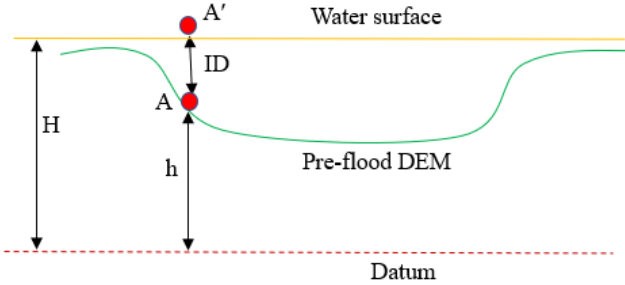
Figure 3. A schematic description of inundation depth estimation. Figure 3 represents a cross-section of a 3D water surface or mask (yellow line) and a cross-section of the pre-flood DEM and datum that are shown by green profile and red dashed line, respectively. H is the elevation of the water surface above the datum, h is the elevation of the earth's surface before the flood event, and ID is the inundation depth. Assume A is a point (pixel) on the earth's surface and A′ is the location of the correspond- ing point on the water surface (inundation area). The pre-flood DEM is considered as a benchmark to estimate the floodwater depth. The elevation difference between the 3D water surface (H) and its corresponding pixel point on the DEM (h) gives the inundation depth (ID): ID = H – h (1) 3.4. Evaluation and Comparison The proposed approach's performance was evaluated using the gauge station eleva- tion obtained from the USGS website. The root mean squared error (RMSE) assessment technique was used to quantify the floodwater depth error calculated using the proposed methods. RMSE is used to measure how well a given model performs. Two RMSEs were calculated to quantify the floodwater depth error calculated using our two proposed methods: a) SfM and deep learning classification, and b) deep learning, DEM, and spatial analysis. Based on the RMSE results, the two methods' performance were compared, and a conclusion was made. 4. Implementation The methodology for flood extent mapping and water depth measurements was im- plemented using MATLAB, Pix4Dmapper, and ArcGIS. The computing unit was config- ured with 32 GB memory, an Intel(R) Xeon(R) ES-2620 v3 @ 2.40GHz ×2 processors memory, and a single NVIDIA Quadro M4000 GPU. 4.1. Flood Extent Mapping Results The UAV images were classified using FCN-8s to extract the flood extent map. Figure 4 illustrates the classification results (water, building, vegetation, and others), and the de- tailed information on the performance of each classifier is described via the confusion ma- trix in Table 1. As previously mentioned, vegetation and building polygons were needed to modify the 3D water surface (3D inundation map) at building–water and vegetation– water interfaces. The overall accuracy and kappa index achieved by FCN-8s were about 97% and 0.934, respectively. For more detailed information on the implementation of stage 1 (deep learning image classification) please see [18]. Our primary goal was to extract inundation areas (water class) from the UAV imagery. The FCN-8s achieved 98.71% accuracy in extracting the in- undation areas in non-vegetated areas from the UAV imagery. Having an accurate flood